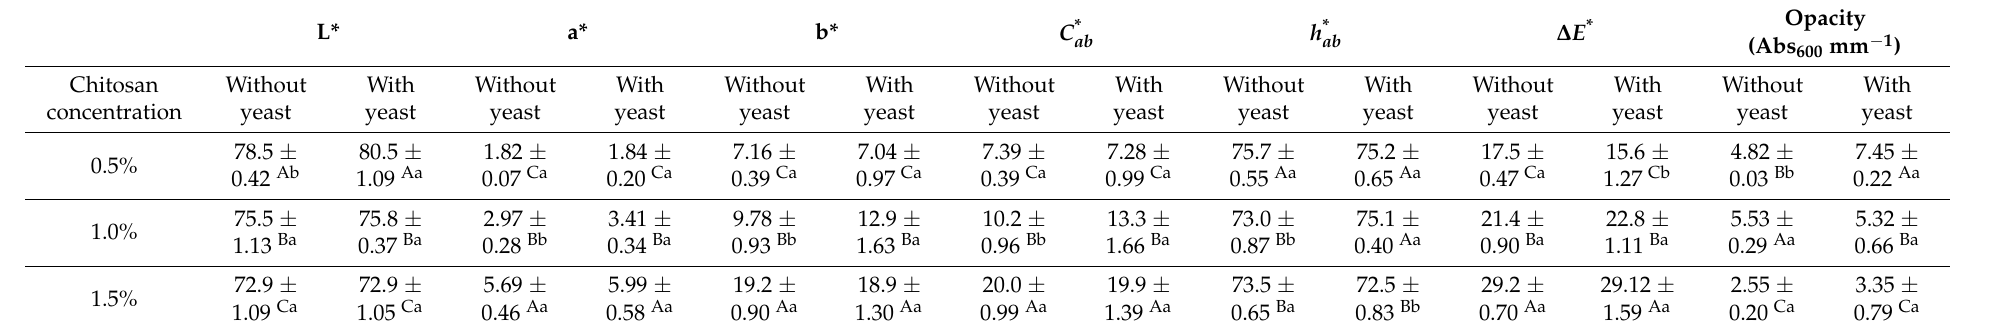
Table 2. Optical properties of chitosan films with or without